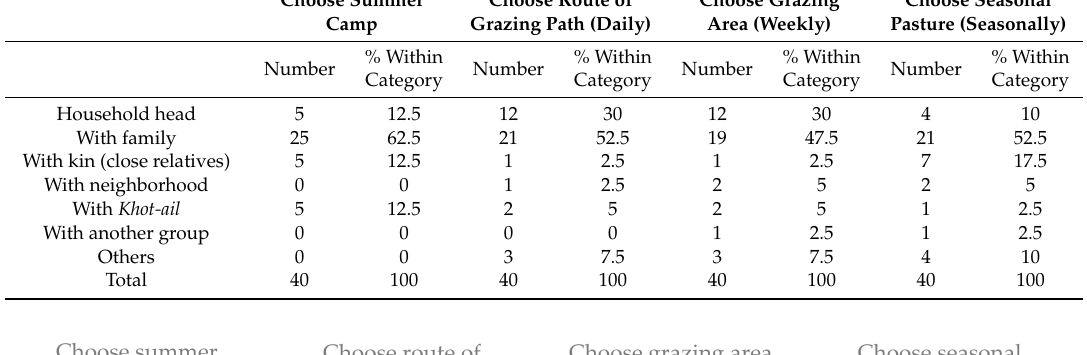
Table 3. Adviser consulted when selecting the summer camp, grazing path, area, and pasture. Choose Summer Choose Route of Choose Grazing Choose Seasonal Camp Grazing Path (Daily) Area (Weekly) Pasture (Seasonally)